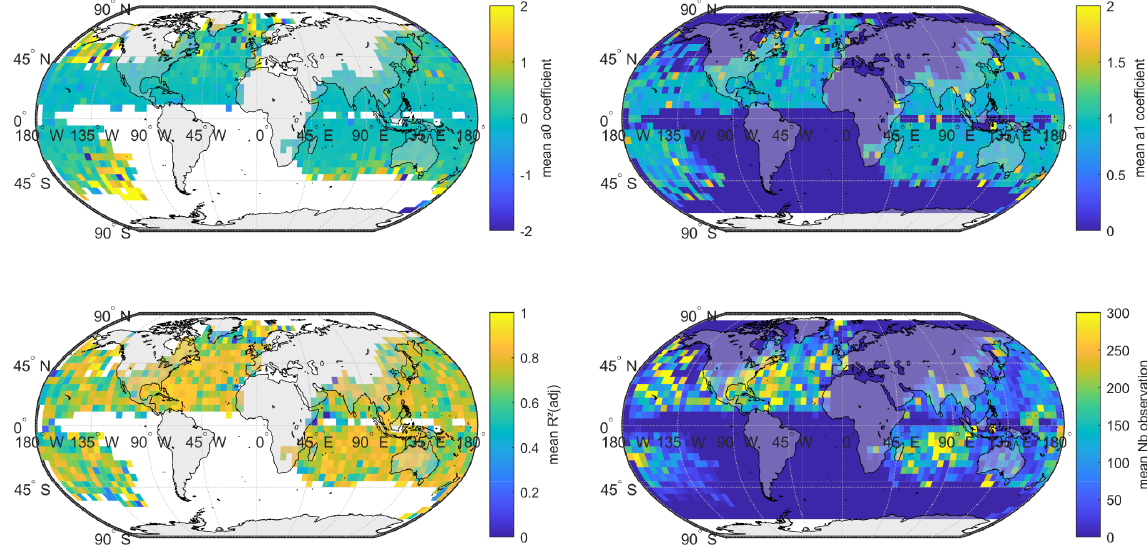
Figure A2. Map of longitude variation mean coefficients fitted on a 5 × 5 grid grouped per month.